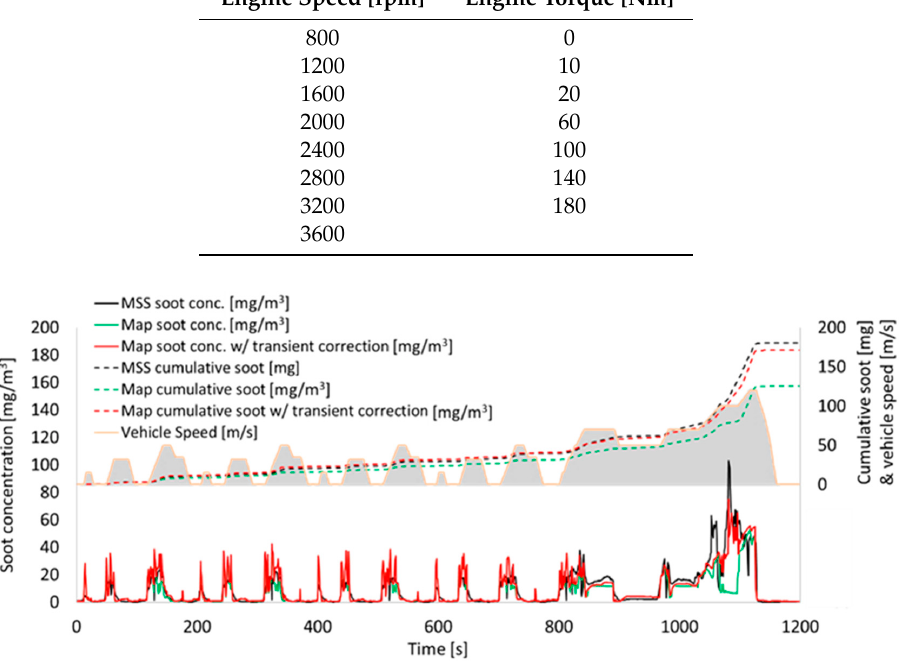
Figure 12. Example of an NEDC. Soot models (base map and base map with transient correction) compared to micro soot sensor (MSS) measurement. The base model is improved with the transient correction.